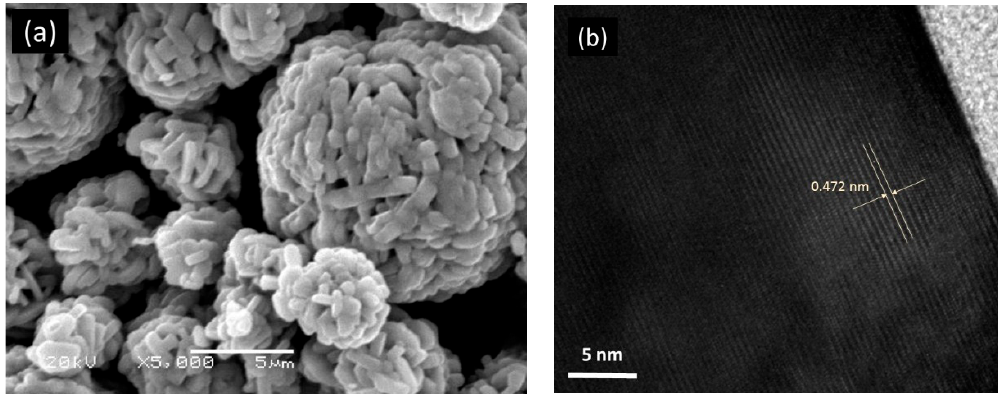
Figure 9. SEM ( a ) and HRTEM ( b ) images of Li 1.04 Ni 0.32 Mn 0.32 Co 0.32 O 2 powders synthesized the co-precipitation method from hydroxide precursor assisted by ammonium and sodium hydroxides.